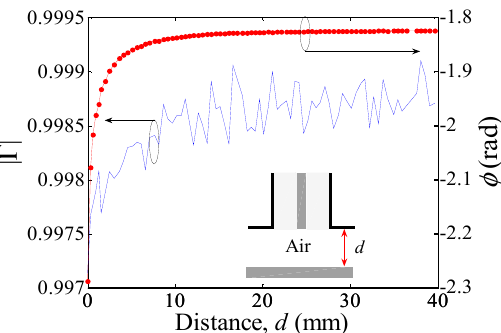
Figure 4. Variation in magnitude and phase of reflection coefficient with distance at 2 GHz.